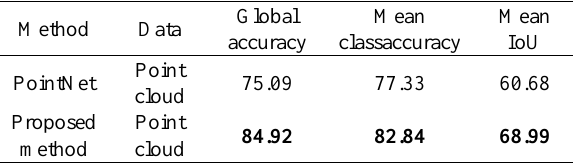
Table Ⅱ Accuracy comparison of overall classification accuracy, the best performance is marked with BOLD